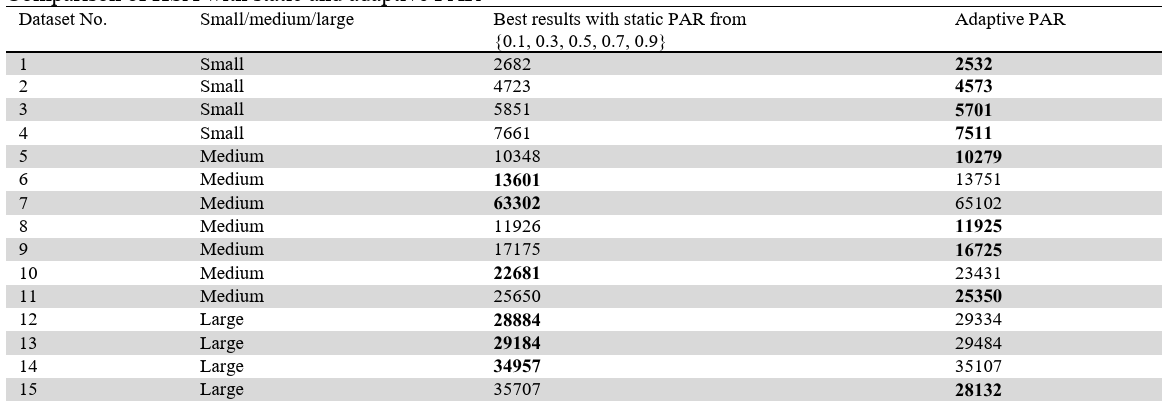
Comparison of HSA with static and adaptive PAR Dataset No.